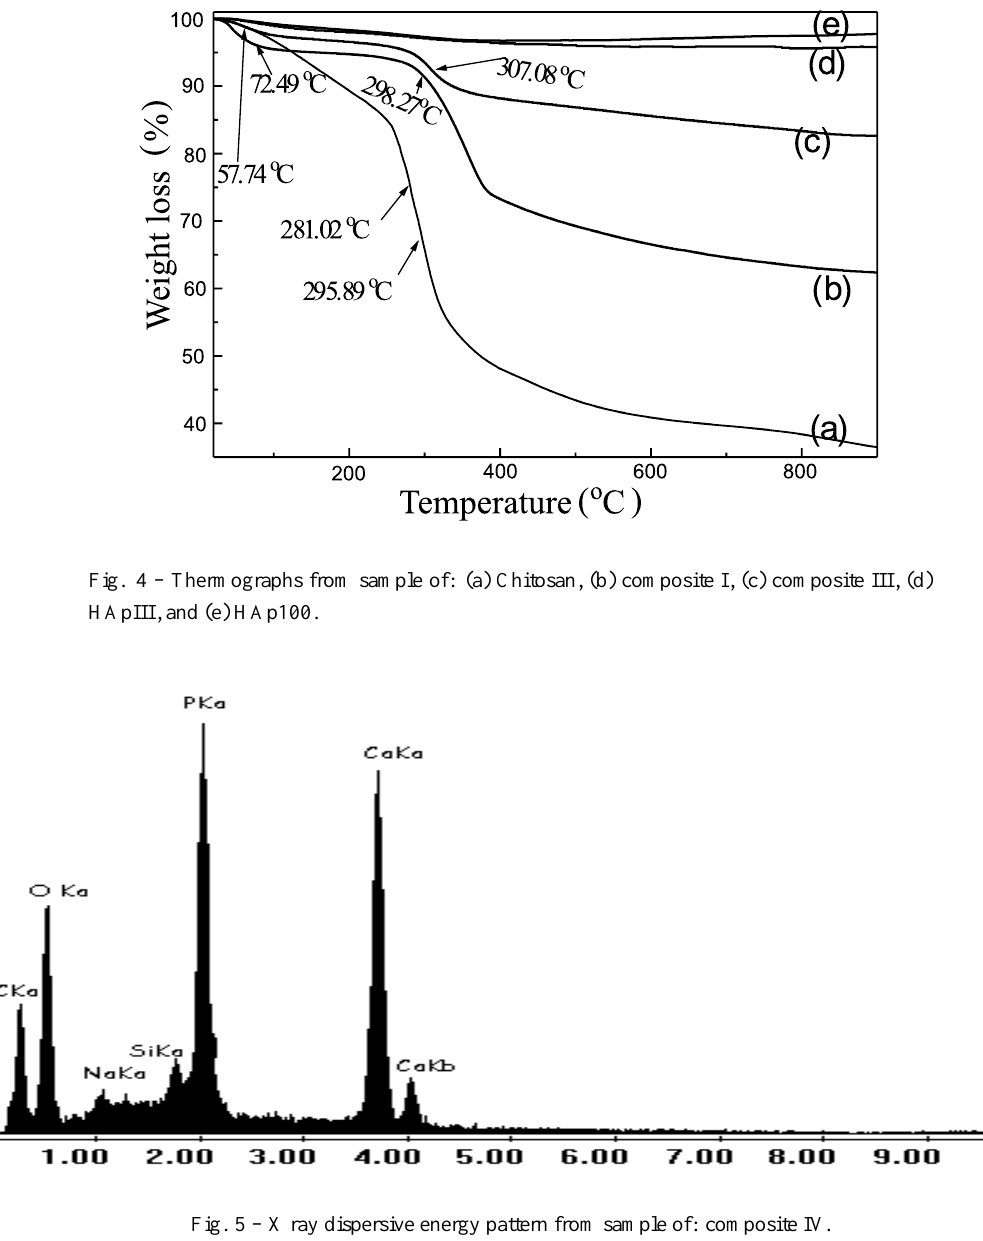
Fig. 5 – X ray dispersive energy pattern from sample of: composite